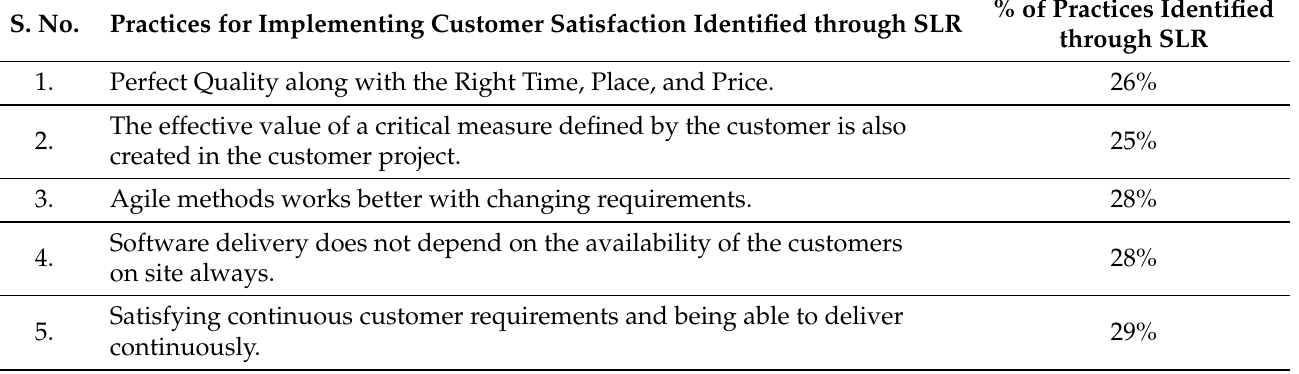
Table 10. Practices for implementing customer